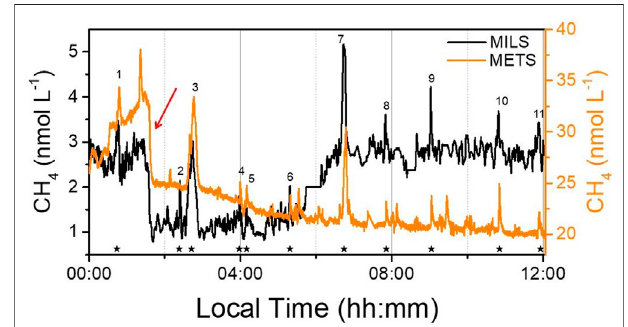
FIGURE 3 | Comparison between the dissolved methane measurements from the MILS and the METS sensor which were deployed simultaneously during the 12 h HP01 survey. The red arrow indicates a sharp concentration decrease observed by both instruments. Well localized peaks of dissolved CH 4 were observed by both instruments (main identi fi ed methane peaks are numbered and identi fi ed by the stars at the